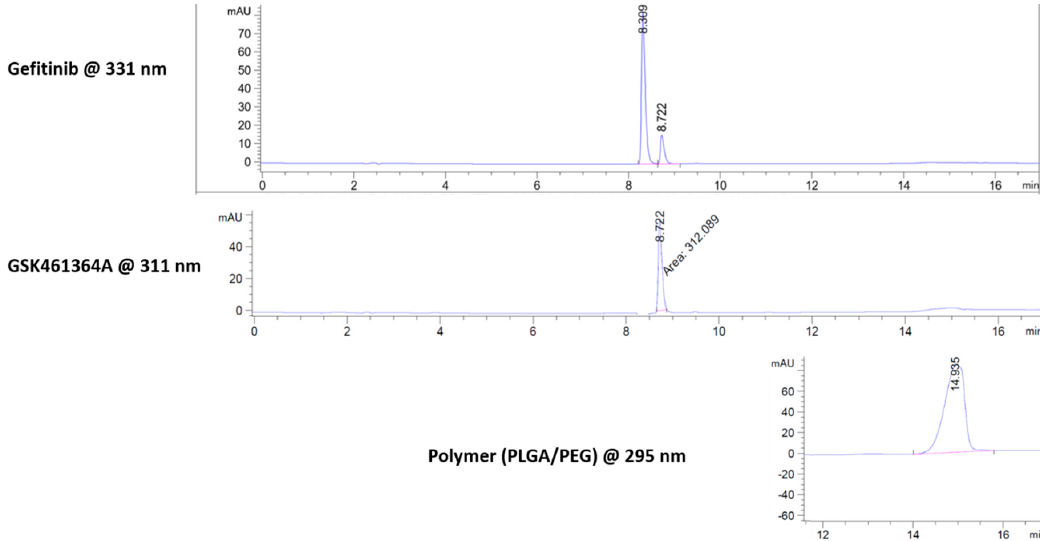
Figure 5. Peak separation of gefitinib, GSK461364A, and polymer (PLGA-PEG) observed in reverse phase HPLC.